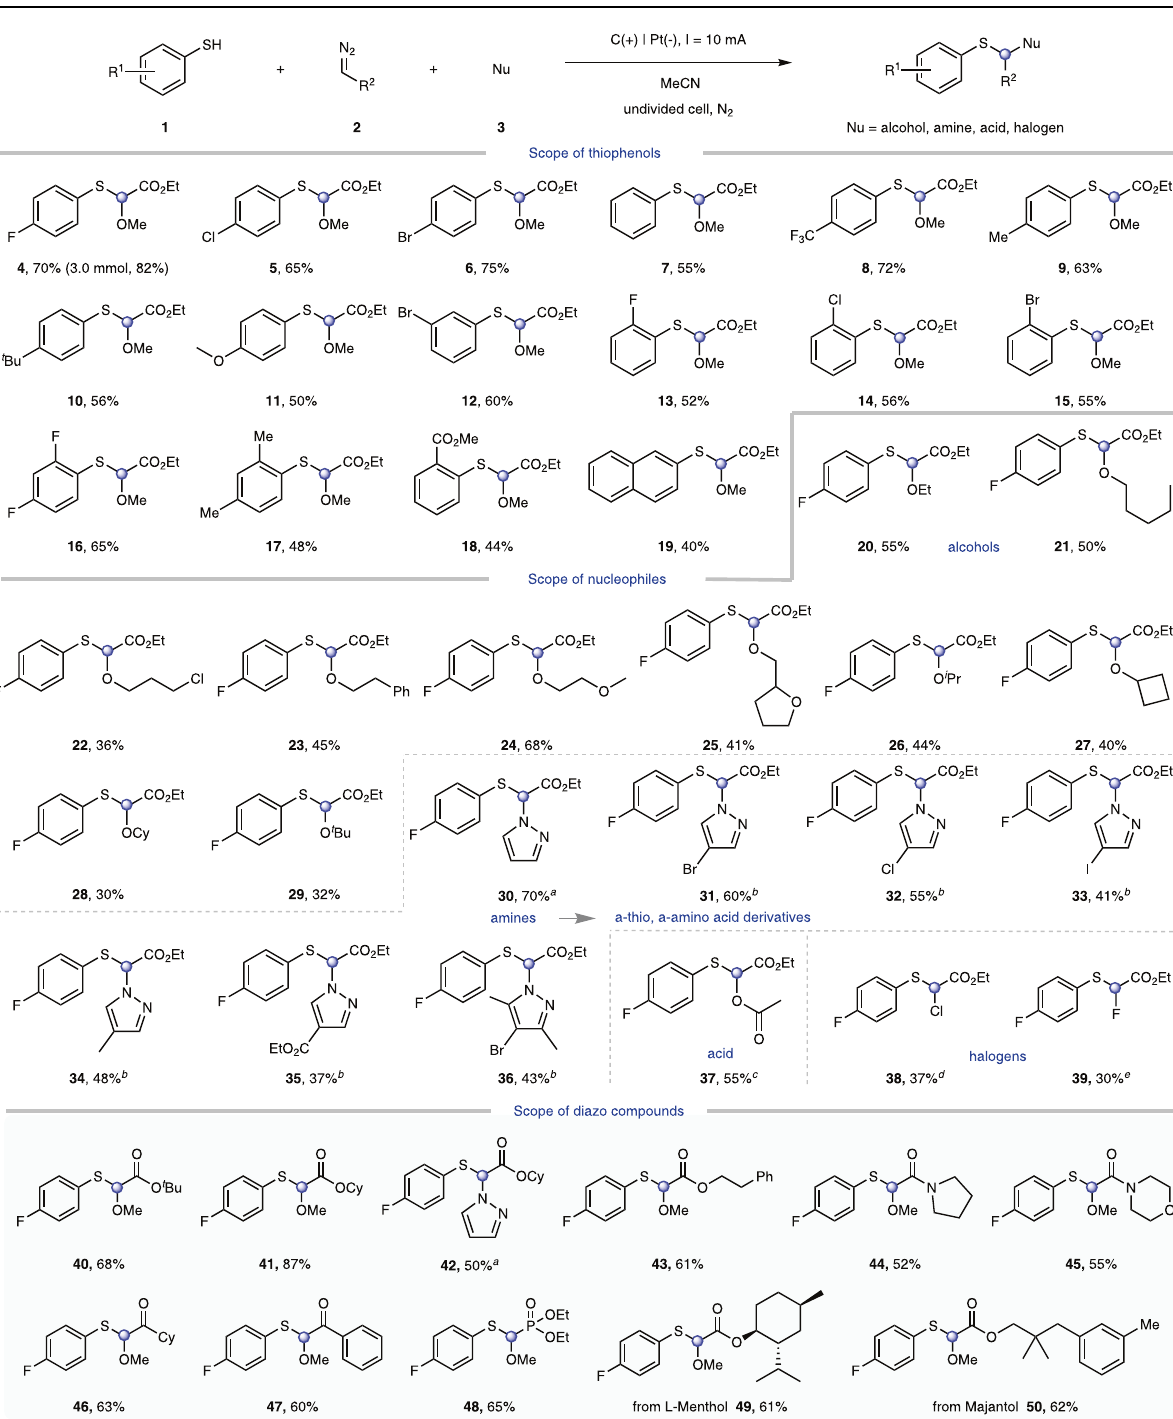
(2.0mmol) instead of alcohol, constant current=10mA, rt, 7h. c Used HOAc (0.5mL) instead of alcohol. d Used LiCl (2.0mmol), H 2 O (50 μ L) instead of alcohol, constant current=10mA, 50 o C, 7h. e Used Et 3 N·3HF (0.5mL) instead of alcohol, constant current=10mA, 50 o C,